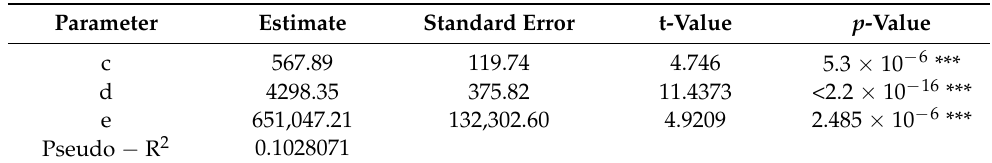
( b ) Figure 10. ( a ) The trained model and ( b ) the scatterplot of the measured vs. predicted canola seed yield for the testing set developed for the image acquired during late flowering (Model 3). Red line indicates the 1:1 line. Table 6. Parameter estimates of the trained simple linear regression model for the cumulative flower area. Parameter